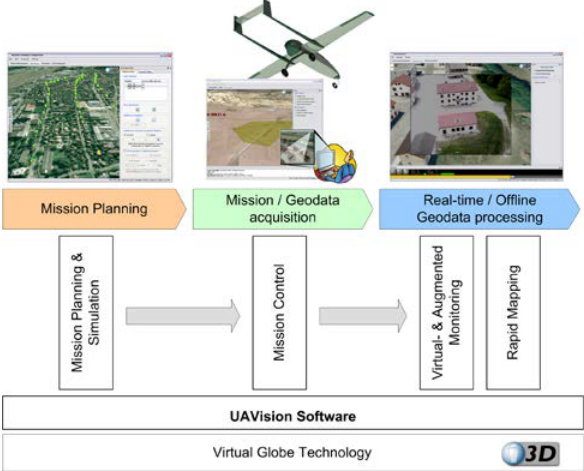
Figure 4: UAVision software modules for UAV